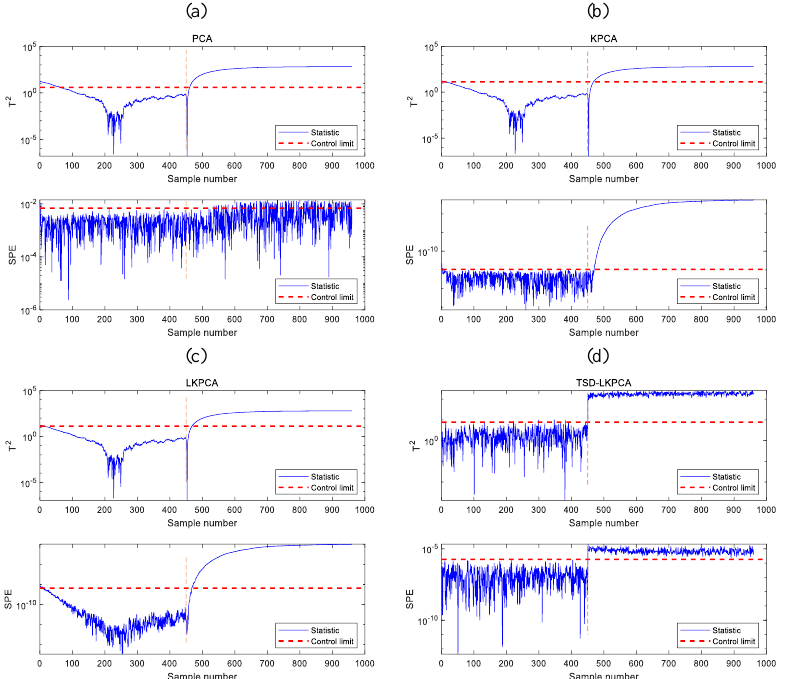
Figure 4. Monitoring charts of fault 1 in the numerical example: ( a ) PCA, ( b ) KPCA, ( c ) LKPCA ( d ) TSD-LKPCA.